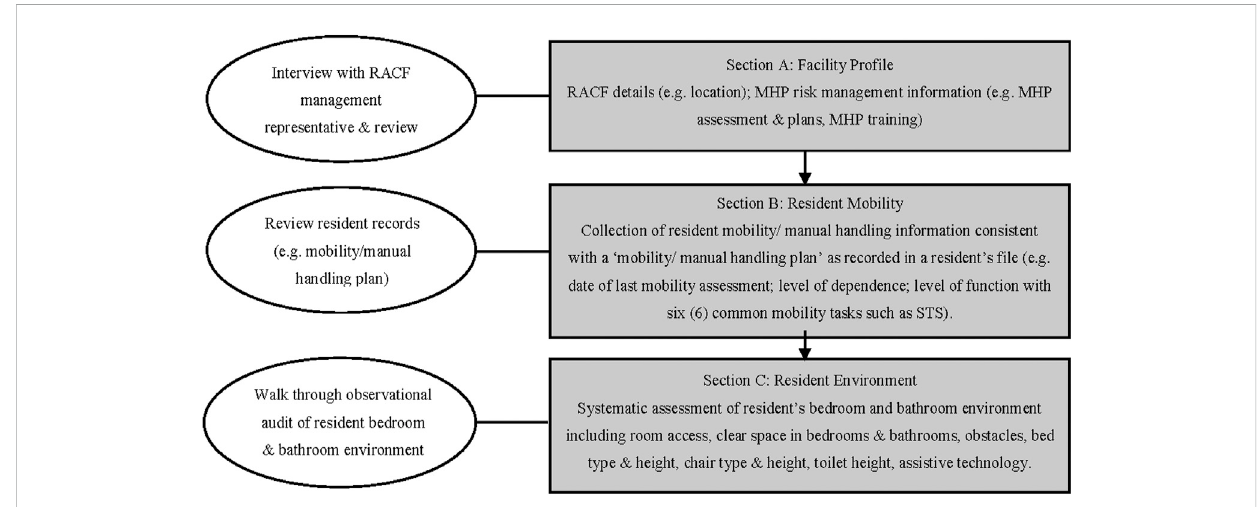
FIGURE 1 OutlineofthesectionsoftheProMobPatient/PersonHandlingAssessmentToolanddatausedfortheassessment(ComanandCaponecchia,2015).